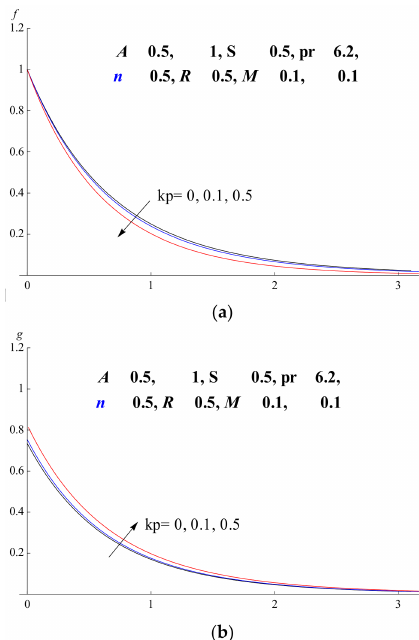
Figure 6. Influence of the porous media parameter ( kp). ( a ) Velocity profile and ( b ) Angular velocity profile.